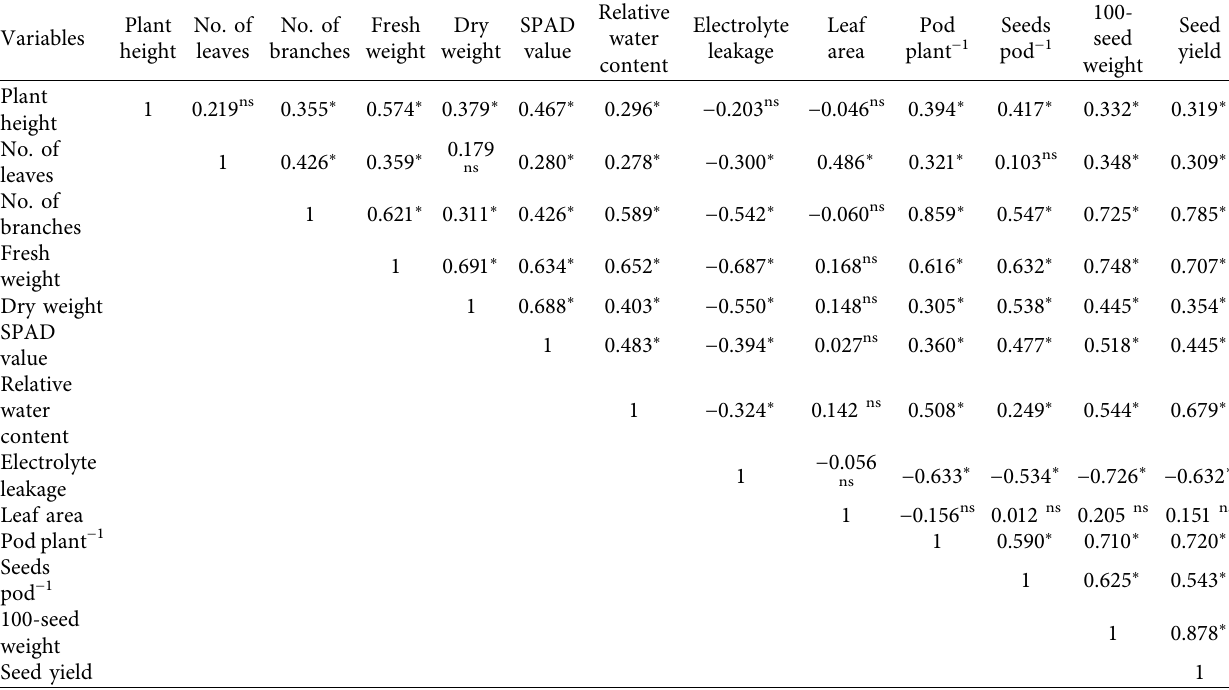
Table 2: Correlation matrix of different parameters activities observed in different soybean genotypes under waterlogging stress condition. Variables